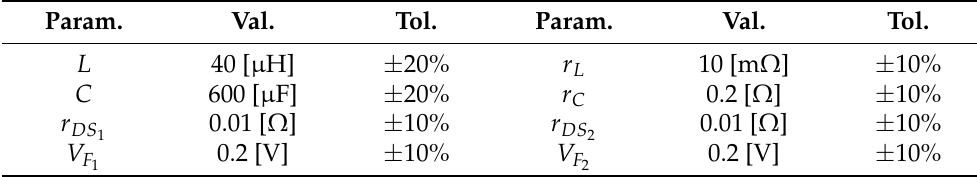
Table 3. Buck and boost converter parameters, values, and corresponding tolerances. Param. Val. Tol.